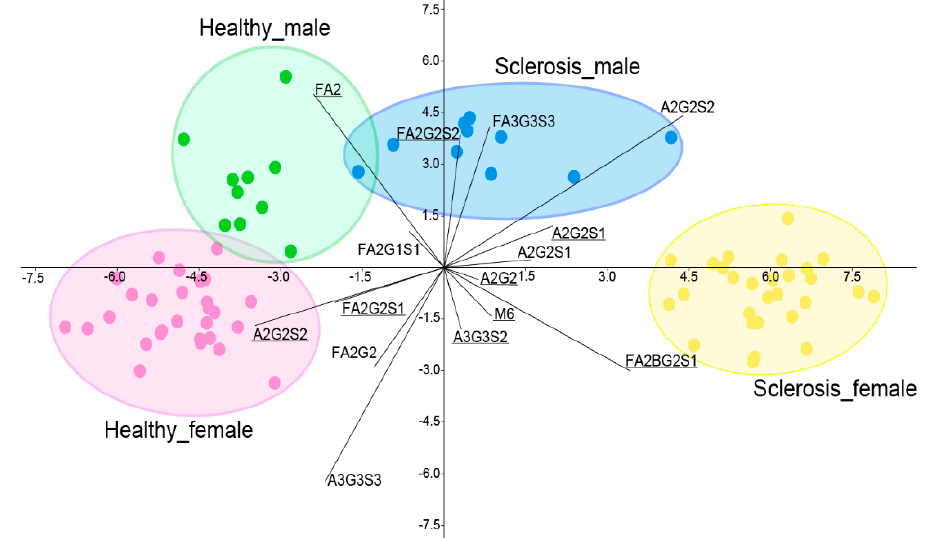
Figure 5. Linear discriminant analysis of female/male MS patients and healthy controls based on their serum N -glycome pattern (significant alterations are underlined).